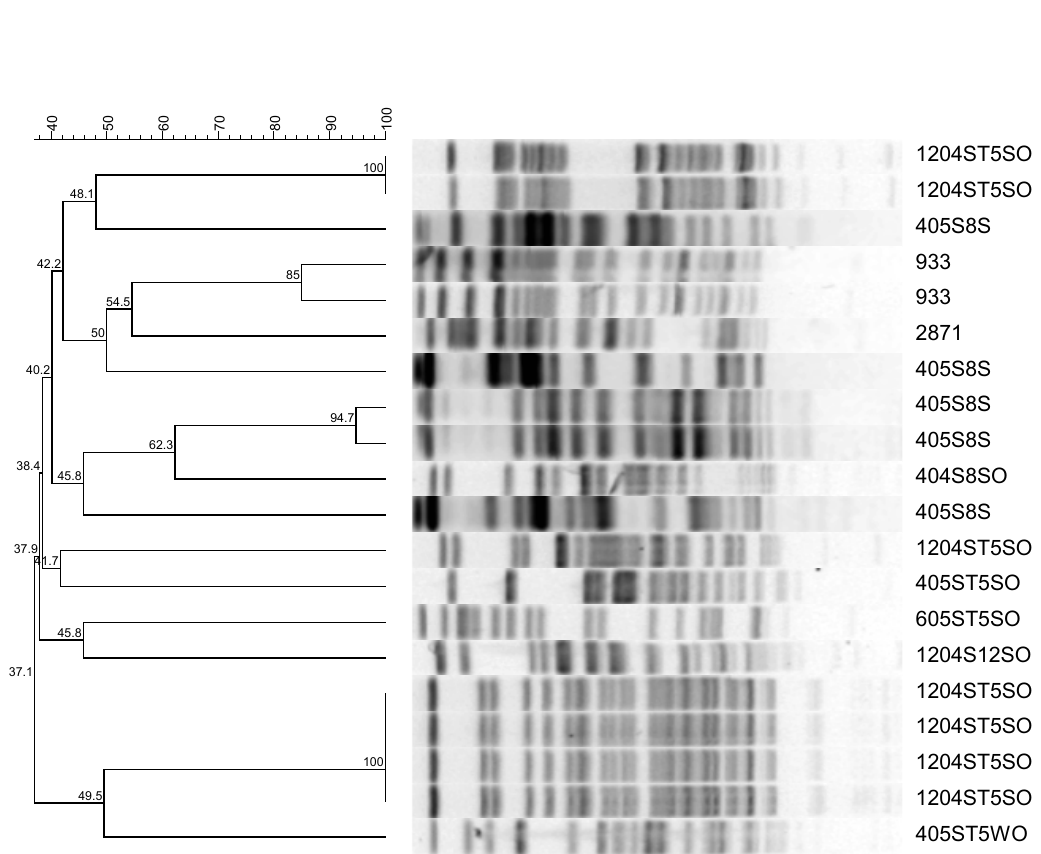
Figure 3. Representative PFGE fragment patterns and dendrogram analysis of potentially pathogenic antimicrobial-resistant E. coli stains from urban watershed impacted by different sources of pollutants. Most of the E. coli isolates were obtained from sediment except one that was obtained from surface water (405ST5 WO). Sample identifications are as follow; e.g., 405S8S and 1204ST5SO indicates month (4 or 12) followed by year (05 or 04), site description (S8 (1 to 6) or ST5-1 to 10 from Table 2), and sample source SO or S (sediment) or water (WO). 933 and 2,871 are pathogenic and nonpathogenic E. coli